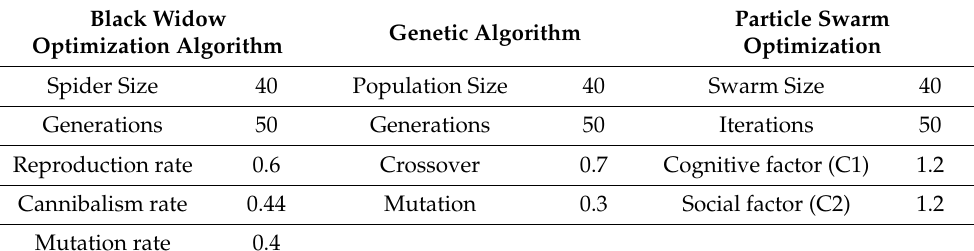
Table 1. Parameters of three different optimization algorithms.